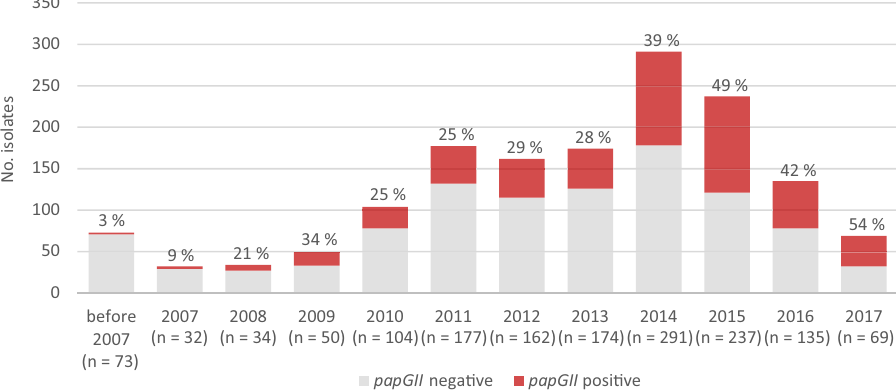
Fig. 3 Proportion of papGII -containing isolates in the ST131 population over time. 1538 isolates from the 11 investigated collections were analysed. The proportion of papGII- containing isolates per year is coloured in red and the percentage is indicated above each bar. The total number of isolates per year is given in brackets. A plot showing the cumulative proportion of papGII -containing isolates is shown in Supplementary Fig. 6.